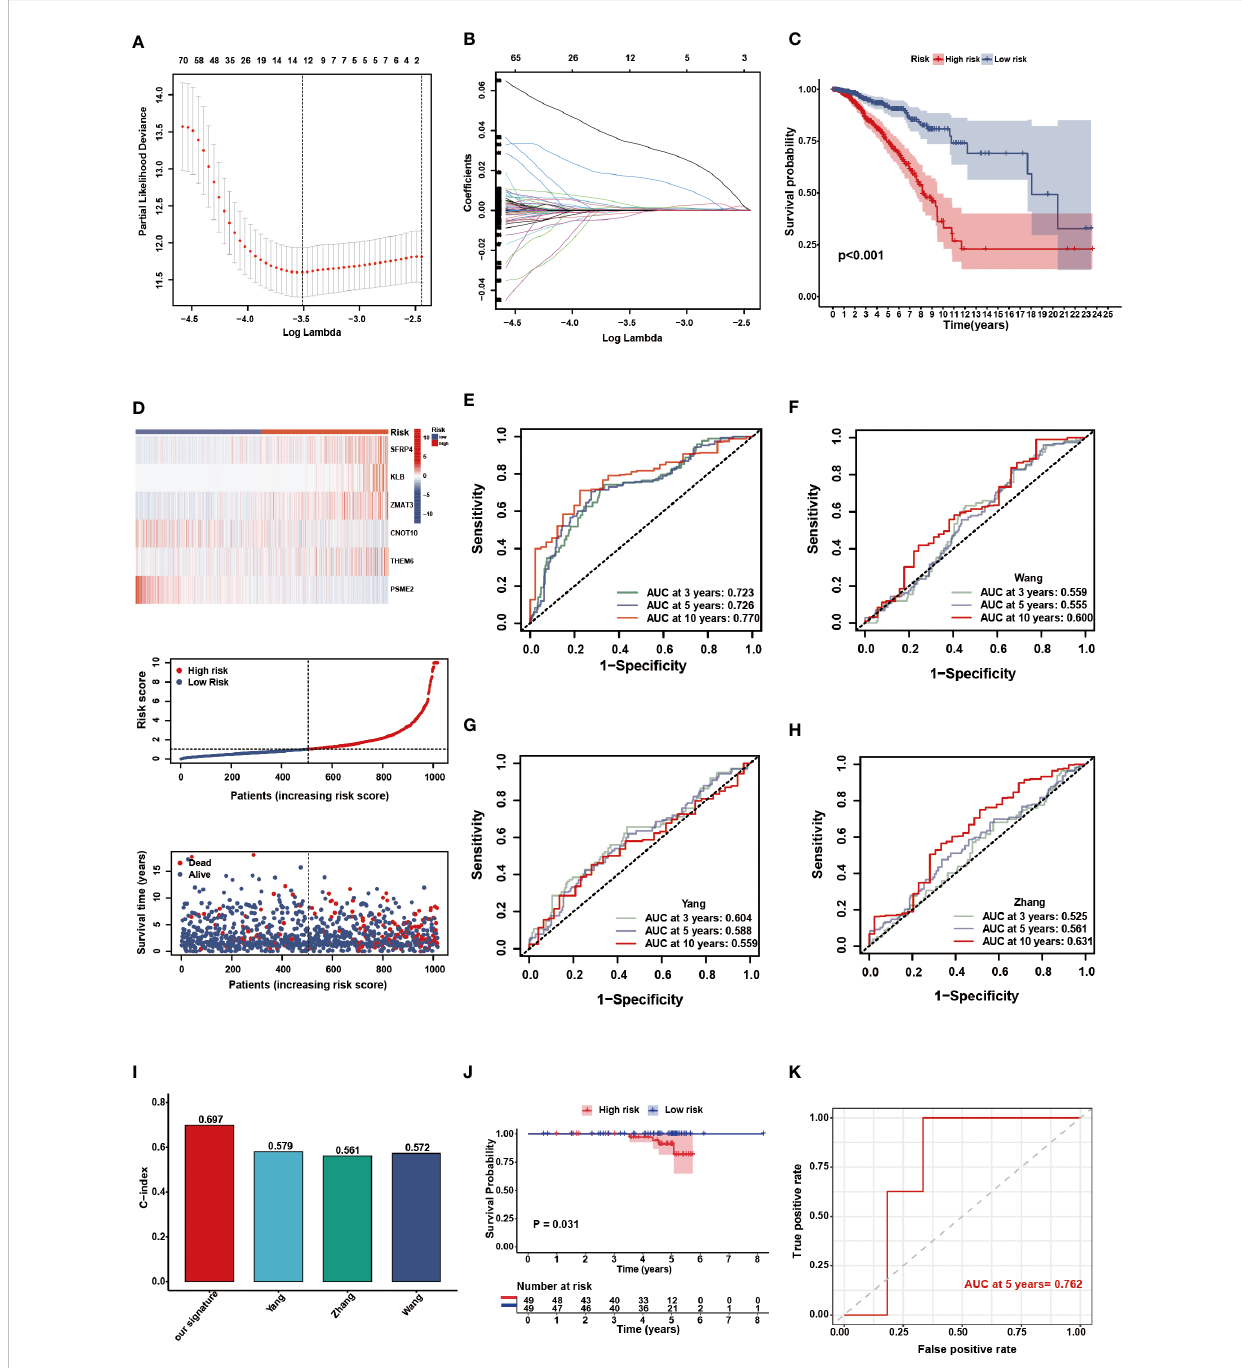
FIGURE 4 Construction and validation of the NMRS. (A) Cross validation method to select optimal genes. (B) The Lasso coef fi cient pro fi les. (C) The OS KM curves between high- and low-risk groups in the TCGA-BRCA cohort. (D) The model genes, risk score and clinical outcomes in the two risk groups. (E) The time-dependent ROC curves of the NMRS. (F-H) The time-dependent ROC curves of Wang ’ s, Yang ’ s and Zhang ’ s gene signature. (I) C-idex of our signature, Wang ’ s, Yang ’ s and Zhang ’ s signature. (J) The OS KM curves between high- and low-risk groups in the ICGC cohort. (K) The time- dependent ROC curves of the NMRS in the ICGC